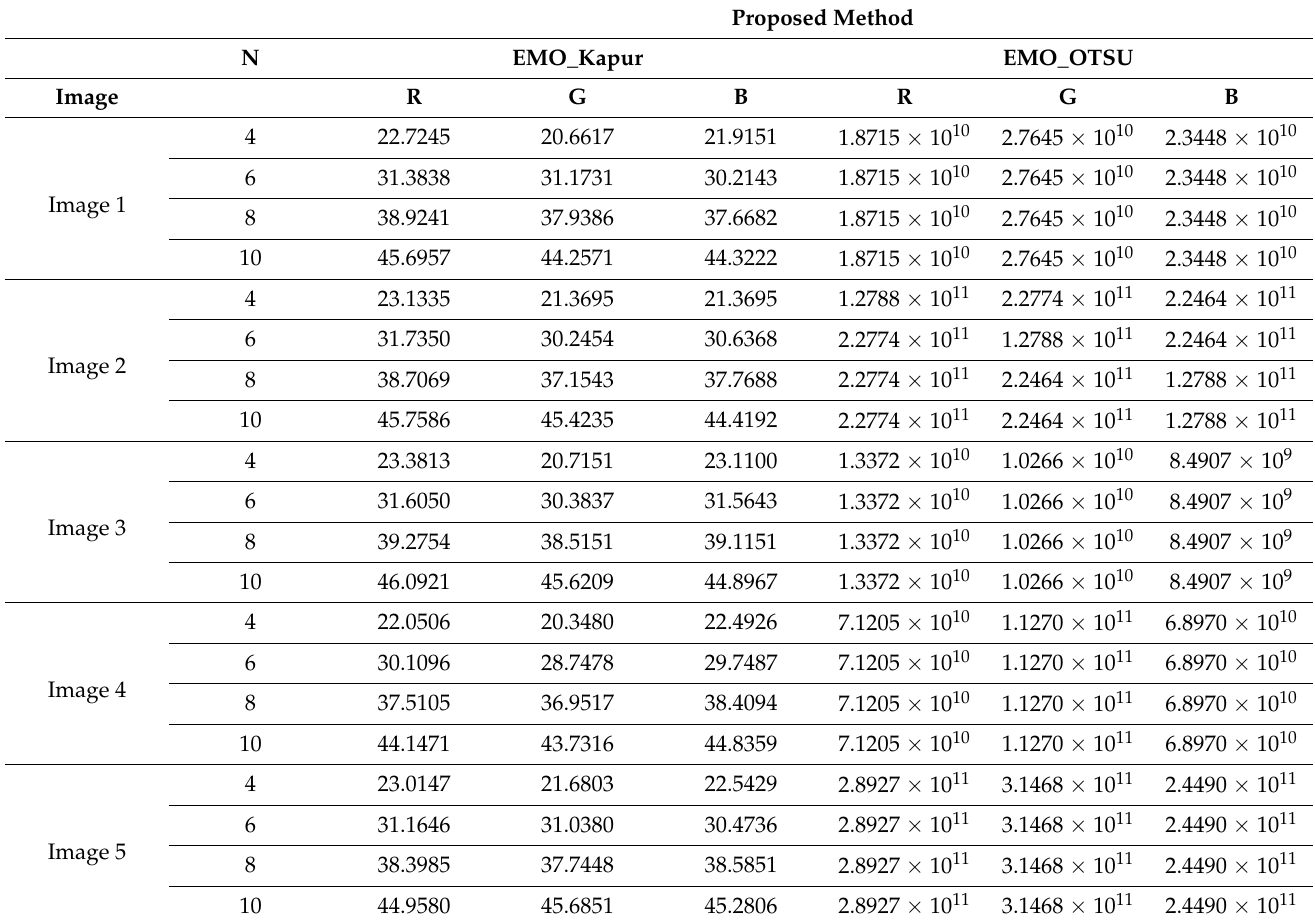
Table 8. Comparison of MEAN computed by SAMFO-TH, MVO, WOA, FPA, SCA, ACO, PSO, ABC, and MFOwith the proposed model using Kapur’s method with N = 4, 6, 8, and